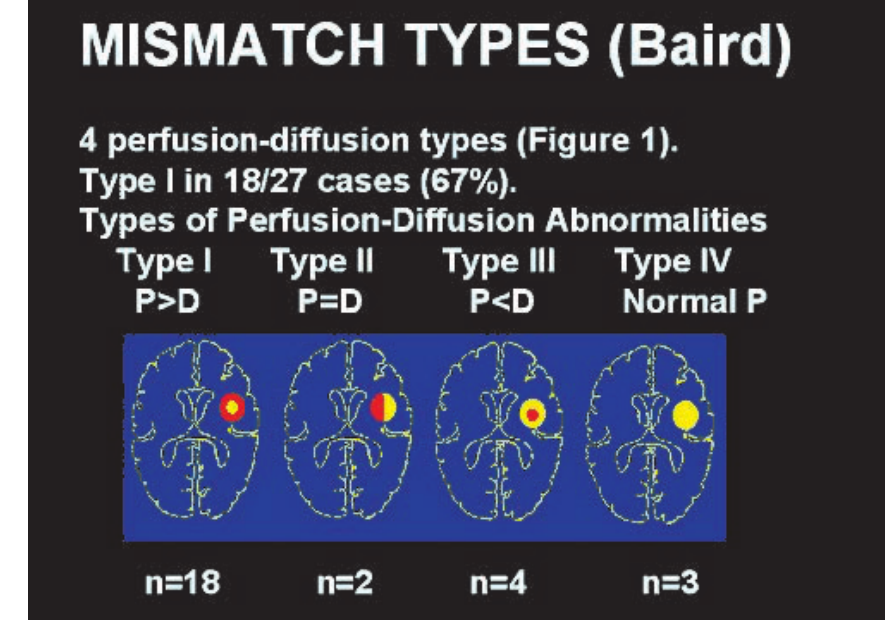
Mismatch types as defined by diffusion and perfusion MR imaging in a series of patients studied by Baird et al. There are mainly four possible types, the most fre- quent being where the central ischaemic core is the diffusion defect which is sur- rounded by a larger area of hypoperfu-